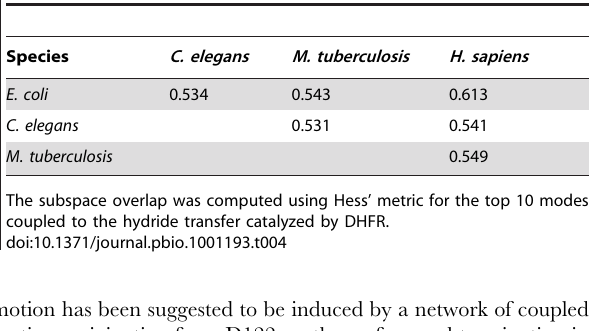
Table 4. Similarity of reaction-coupled modes in